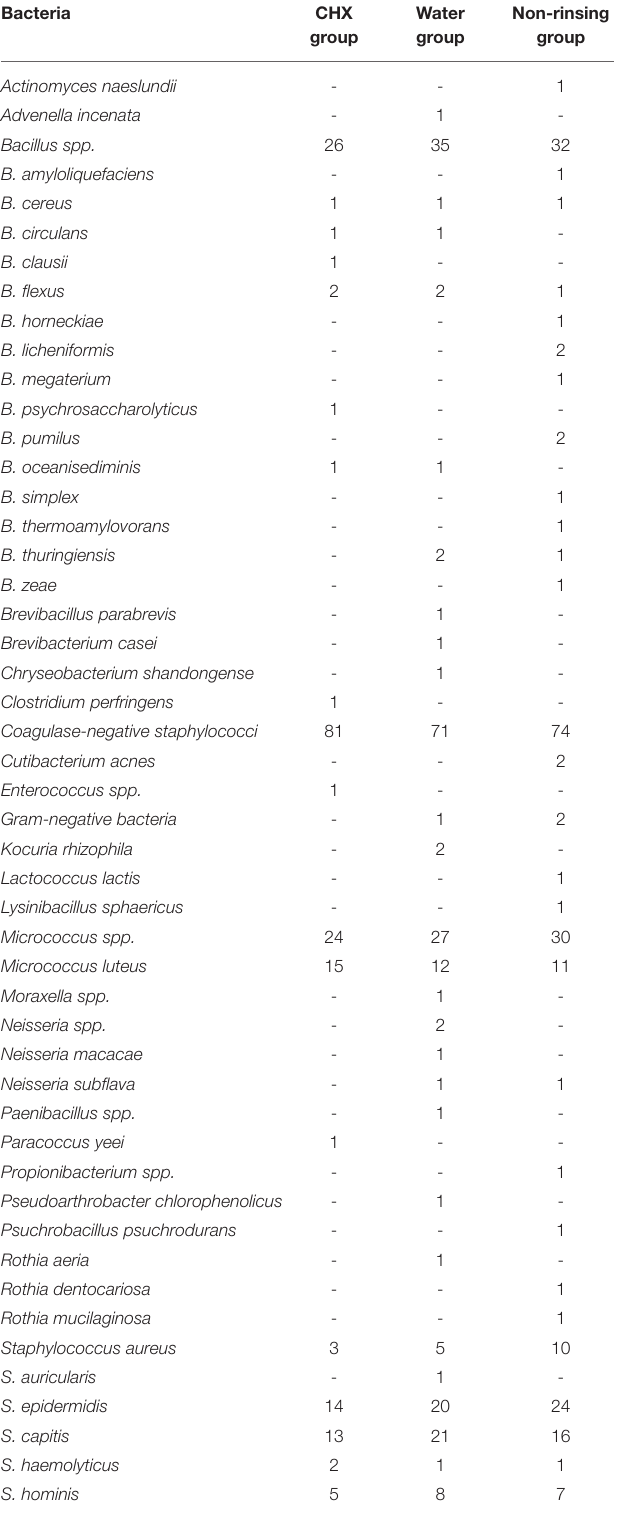
Water Non-rinsing group group group